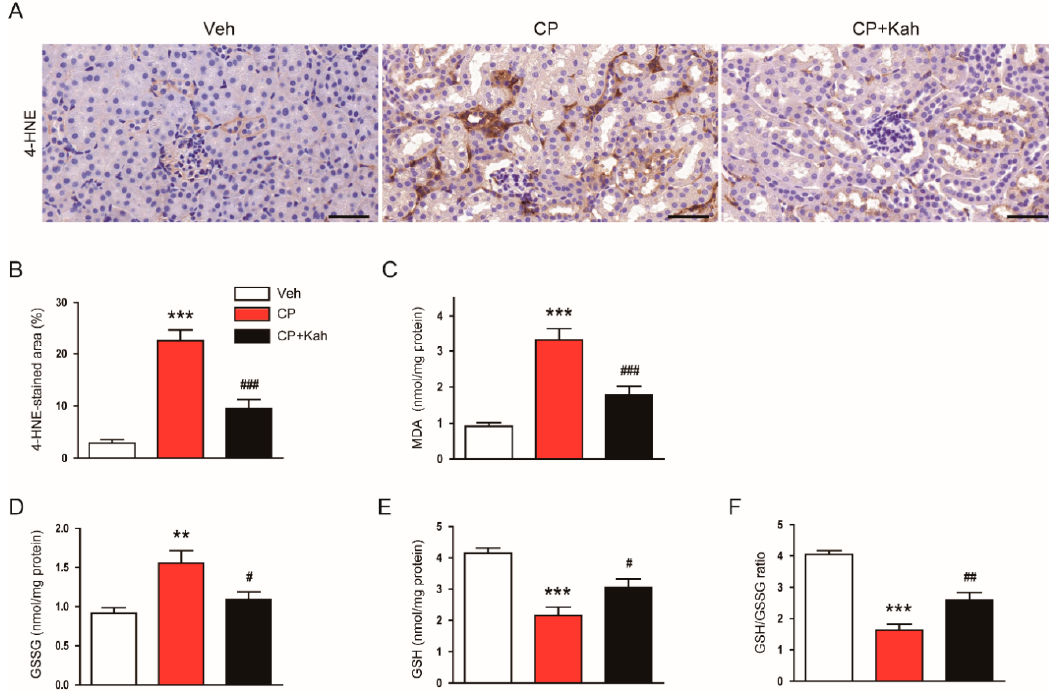
Figure 5. Effect of kahweol on cisplatin-induced renal oxidative stress. ( A ) Immunohistochemical staining of kidney tissues for 4-hydroxynonenal (4-HNE). Scale bar = 100 μ m. ( B ) Percentage of stained areas for 4-HNE. ( C ) Malondialdehyde (MDA) levels. ( D ) Oxidized glutathione (GSSG) levels. ( E ) Reduced glutathione (GSH) levels. ( F ) GSH/GSSG ratio. n = 8 per group. ** p < 0.01 and *** p < 0.001 vs. Veh. # p < 0.05, ## p < 0.01, and ### p < 0.001 vs. CP.